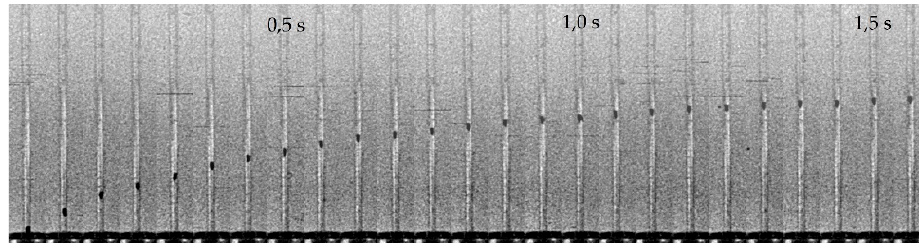
Figure 6. Rotameter no. 1, step 10 dm 3 /h. Selected images captured by a camera.